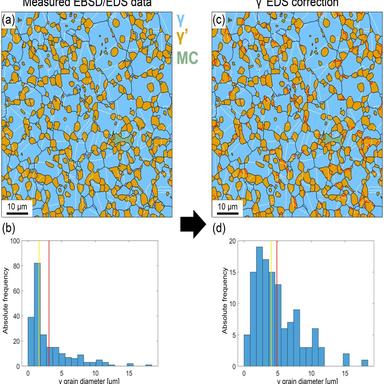
Phase maps of Alloy 1 measured with combined EBSD-EDS (a) before and (c) after EDS correction. GBs with misorientation θ > 5◦ and phase boundaries are marked in black, Σ3 twin boundaries are indicated in white. The grain diameter distribution for γ grains (b) before and (d) after EDS correction; the yellow line and red line indicate the median and mean diameter, respectively.